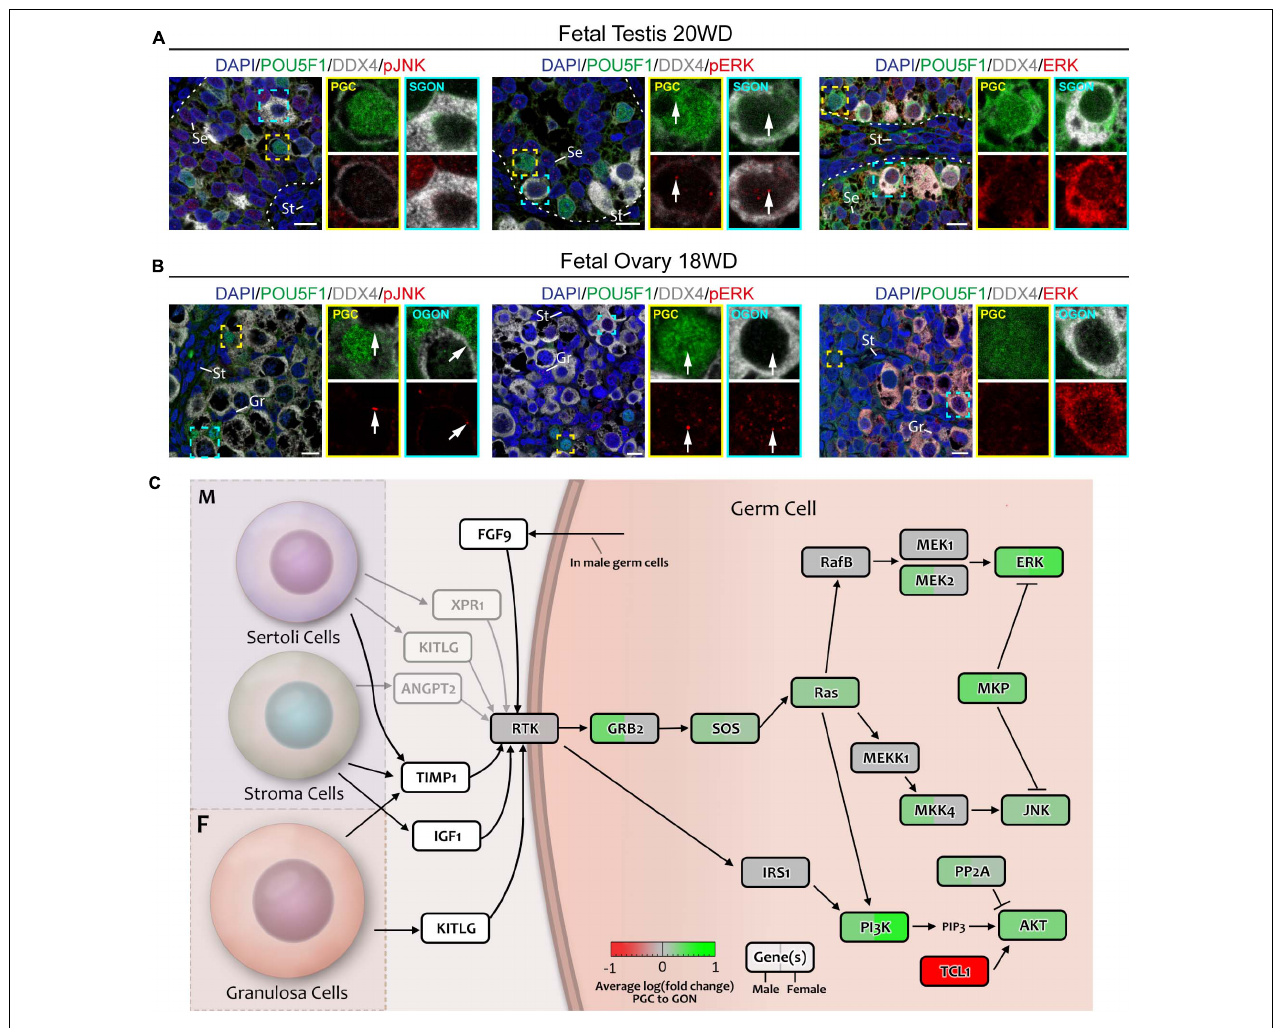
FIGURE 4 | Analysis of MAPK signaling downstream of RTKs in fetal gonads by immunostaining for key (phosphorylated) pathway effectors. (A,B) Immunofluorescence of phosphorylated (p)-JNK, pERK, or ERK with DDX4 and POU5F1 in fetal testis of 20 weeks development (WD) (A) and fetal ovary of 18 WD (B) . No nuclear pJNK is observed in male (A) or female (B) germ cells. Total ERK levels are greatly increased in GONs of both sexes, but this is not accompanied by a corresponding increase in nuclear pERK. Yellow boxes indicate zoom-in of a PGC (POU5F1 + ), and cyan boxes indicate zoom-in of a GON (POU5F1 − ). Se, St, and Gr annotate Sertoli, stromal, and granulosa cells, respectively. Scale bar indicates 10 µ m. (C) A schematic model of RTK signaling axes in germ cells, representing a combination of the results from CellphoneDB analysis and differentially expressed gene analysis. Genes upregulated in GONs are depicted in green, while those upregulated in PGCs are depicted in red. Gray arrows indicate interactions with low mean expression of the